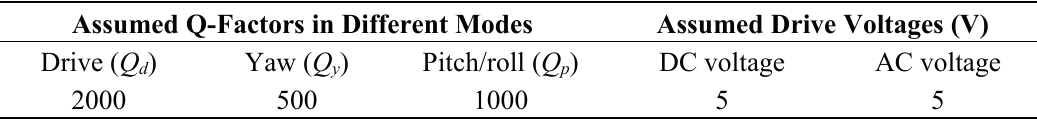
Table 6. Some assumed parameters for simulation.